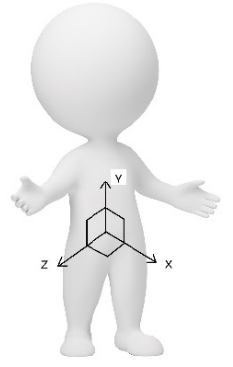
Figure 1. Human activity model.